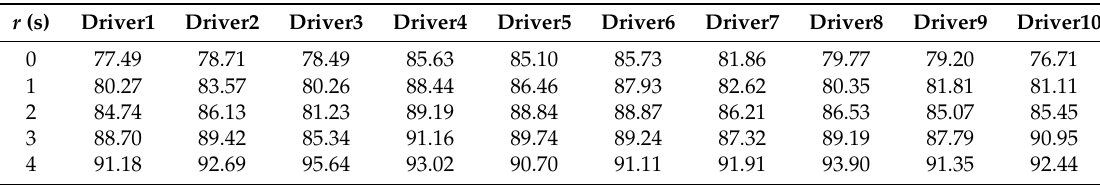
Table 6. Classification accuracy (%) of the testing data (O1).